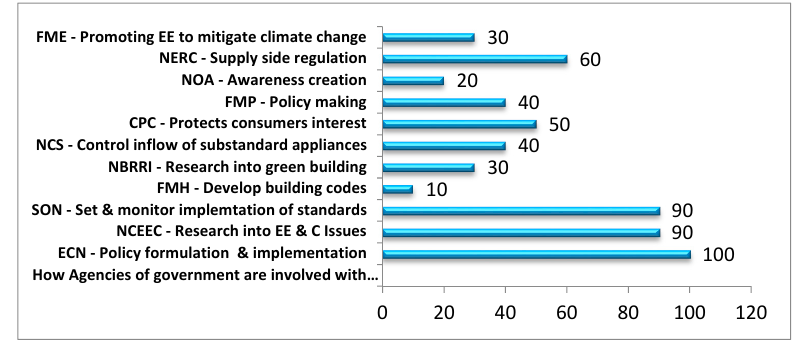
Figure 13. Expert opinions on how government agencies are involved with energy efficiency of